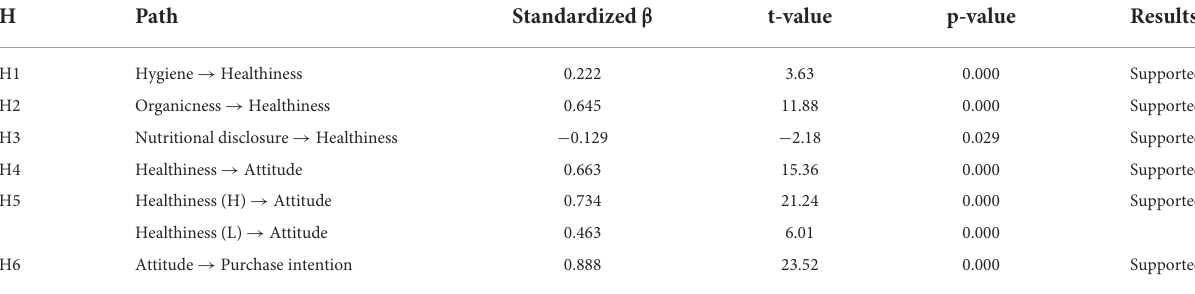
TABLE 5 Results of hypothesis